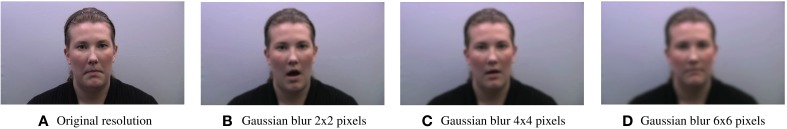
Screenshots of single frames included in the 1-s presentations of the /BA/ syllable, at the original 1024×576 pixel resolution (A), with Gaussian blur at 2×2 pixels (B), Gaussian blur at 4×4 pixels (C), and Gaussian blur at 6×6 pixels (D).